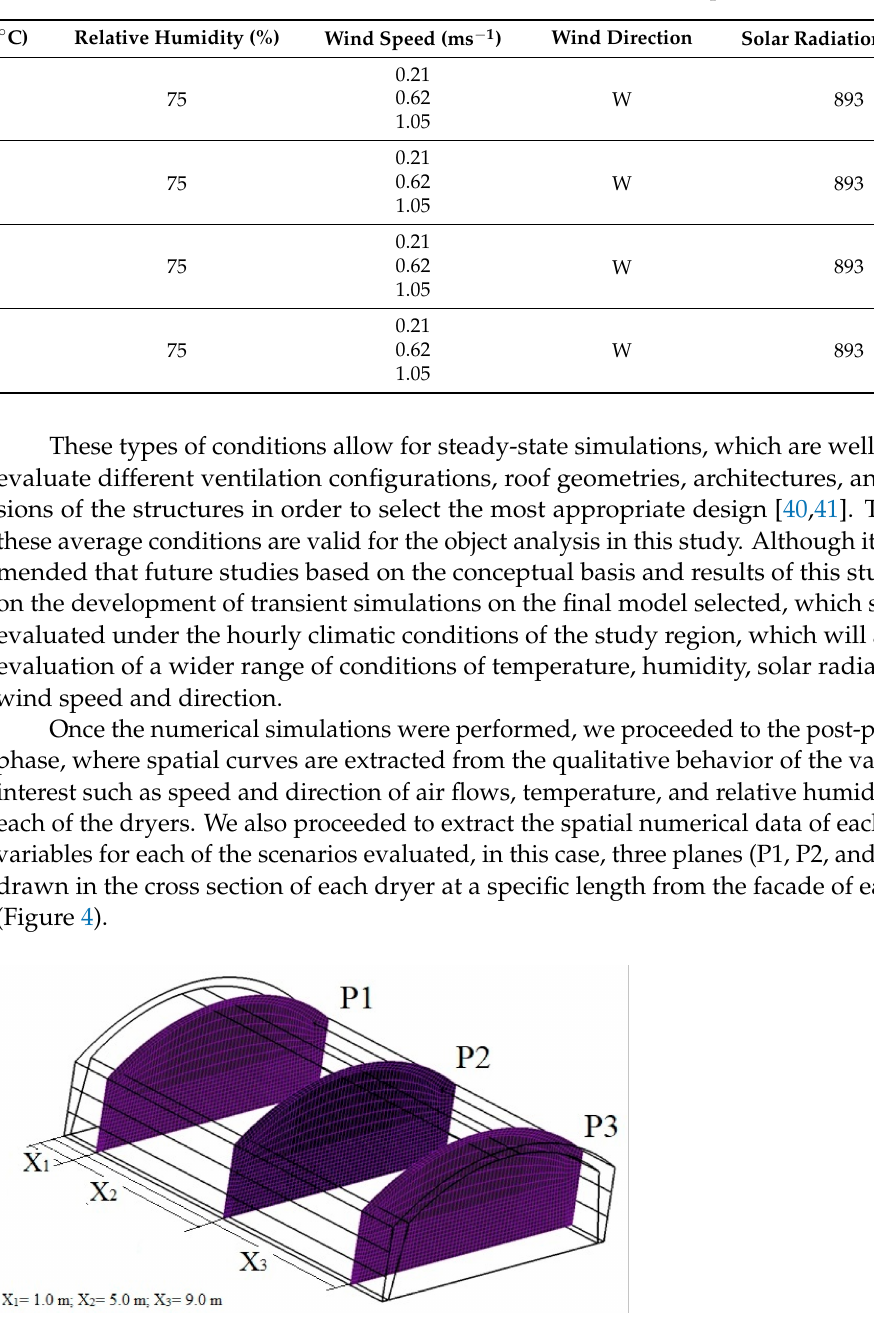
Table 4. Initial conditions used in the CFD simulation of each of the scenarios contemplated.